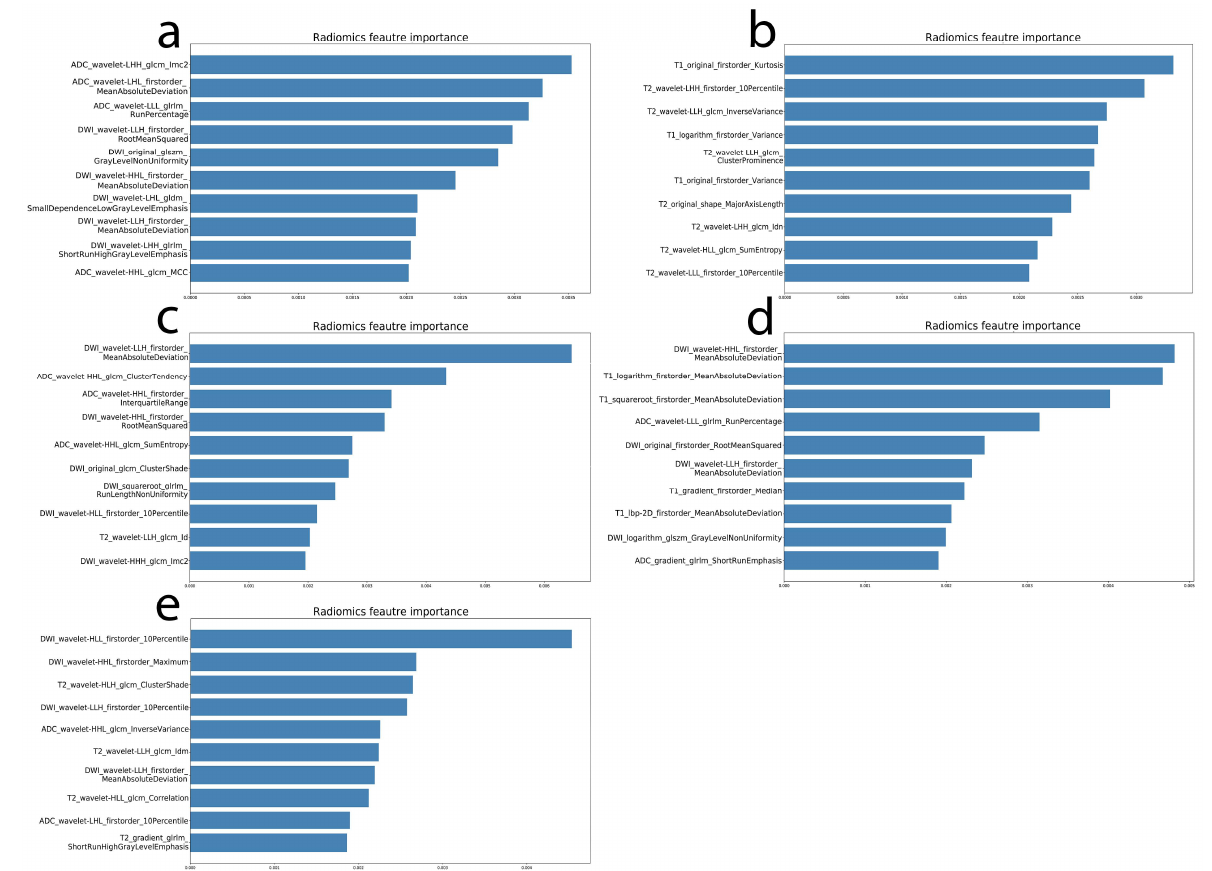
Figure 3. The importance of selected features derived from different sequence combinations: ( a ) DWI + ADC; ( b ) T2WI + CE-T1WI; ( c ) DWI + ADC + T2WI; ( d ) DWI + ADC + CE-T1WI; ( e ) DWI + ADC + T2WI + CE-T1WI.